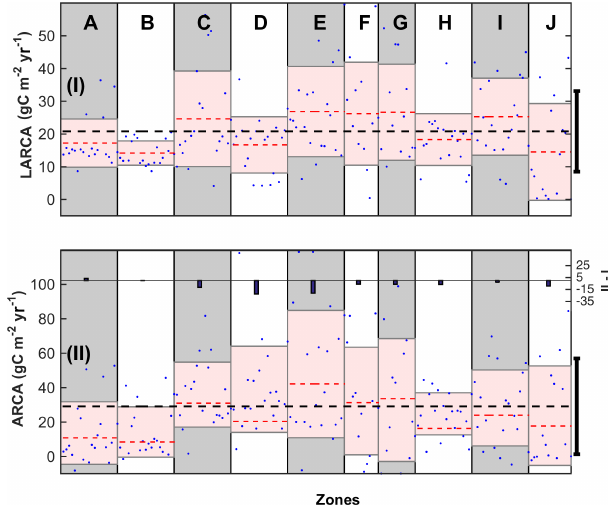
Figure 4. Simulated Holocene peat accumulation rates across the 10 zones considered in this study (blue dots) and for the pan-Arctic region as a whole (dashed black line). The x axis shows the num- ber of sites partitioned into 10 zones. The black dashed line is the pan-Arctic average with standard deviation (black line outside the y axes) and the red dashed line is the average among zones with the standard deviation as a light red patch. (I) Simulated long-term (apparent) rate of C accumulation (LARCA); (II) simulated actual (true) rate of C accumulation (ARCA) for the last 30 years. Blue bars show the difference between ARCA and LARCA mean values for the respective zone (II −